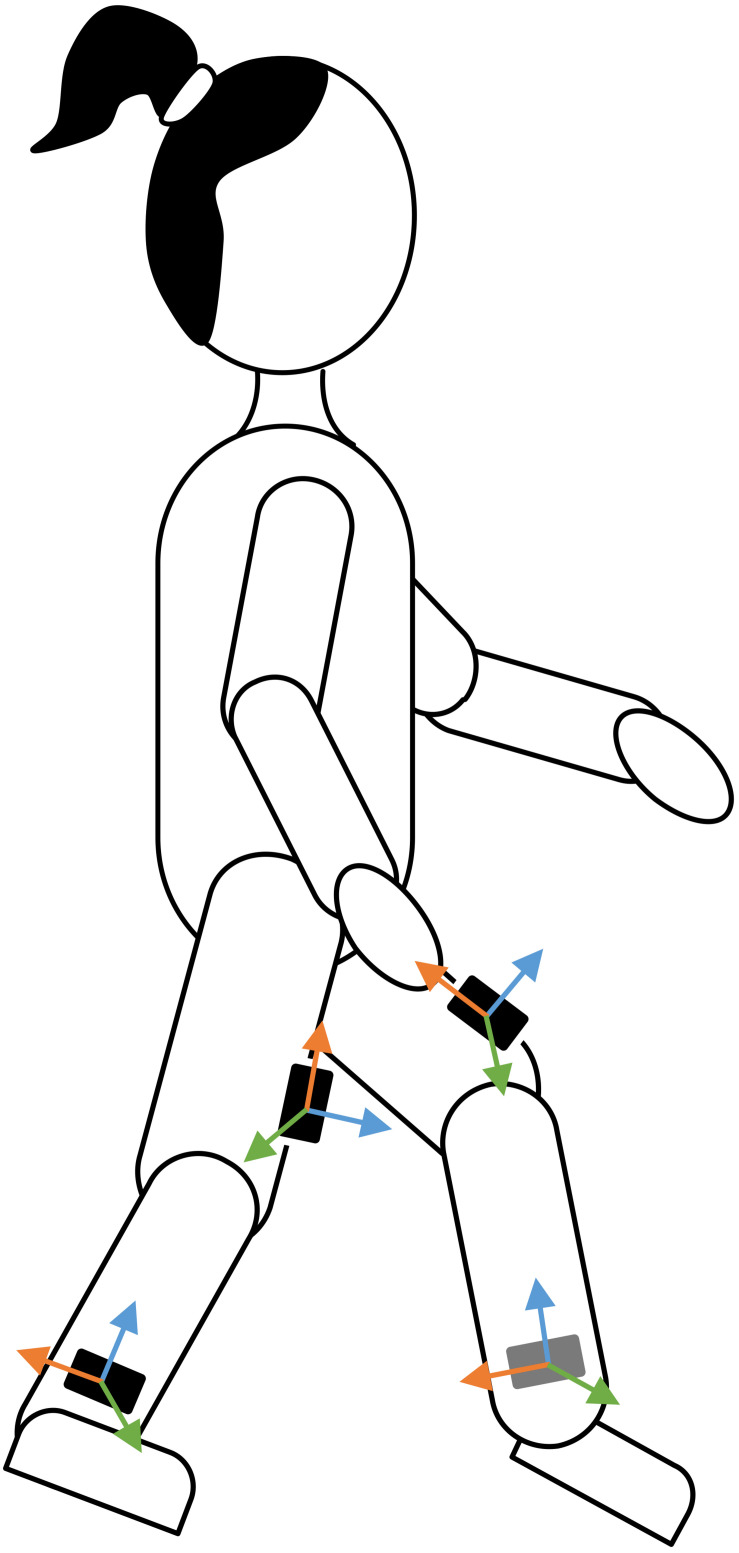
Sensor placement. Four sensors were placed on the participant’s lower limbs. The orientation of the sensors’ axes (colored arrows) was not imposed since the sensor-to-segment alignment was performed in post-processing using the PCA approach described in the section “Data Analysis.”